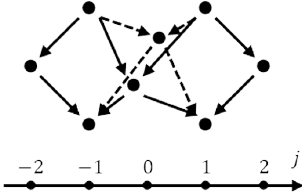
Figure 17: The representation in (C.4). The points represent the operators and the axis labels their spin. This is exactly the second part in the rank-3 tensor representa- tion shown in Figure